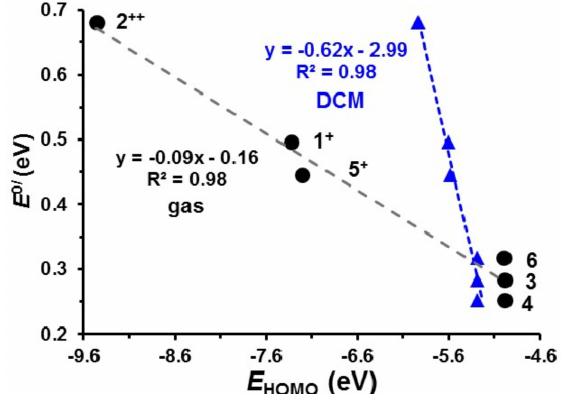
Figure 6. B3LYP / 6-311G(d,p) / def2-TZVPP(SDD) calculated LUMOs of molecules after ferrocenyl oxidation. Calculations was done using DCM as solvent. A contour of 0.06 eÅ –3 was used for the MO plots. Gas phase calculated LUMOs look similar and are provided in the Supporting Information Figure S3.